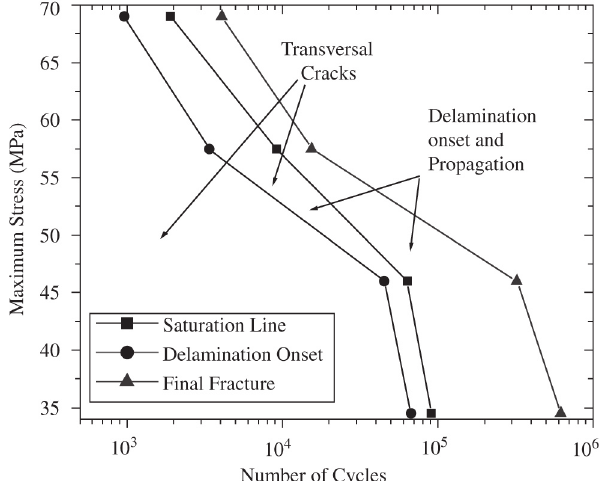
Figure 6. Damage formation and propagation took place in the fol-